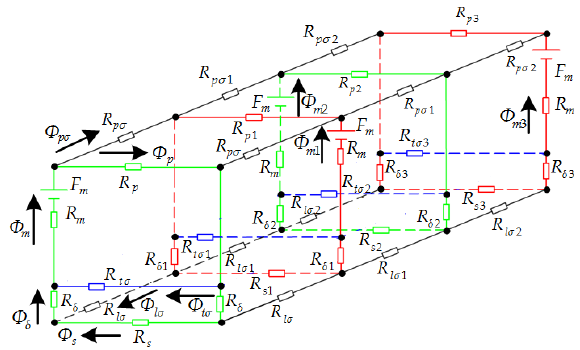
Figure 5. Structure diagram of the unit machine.